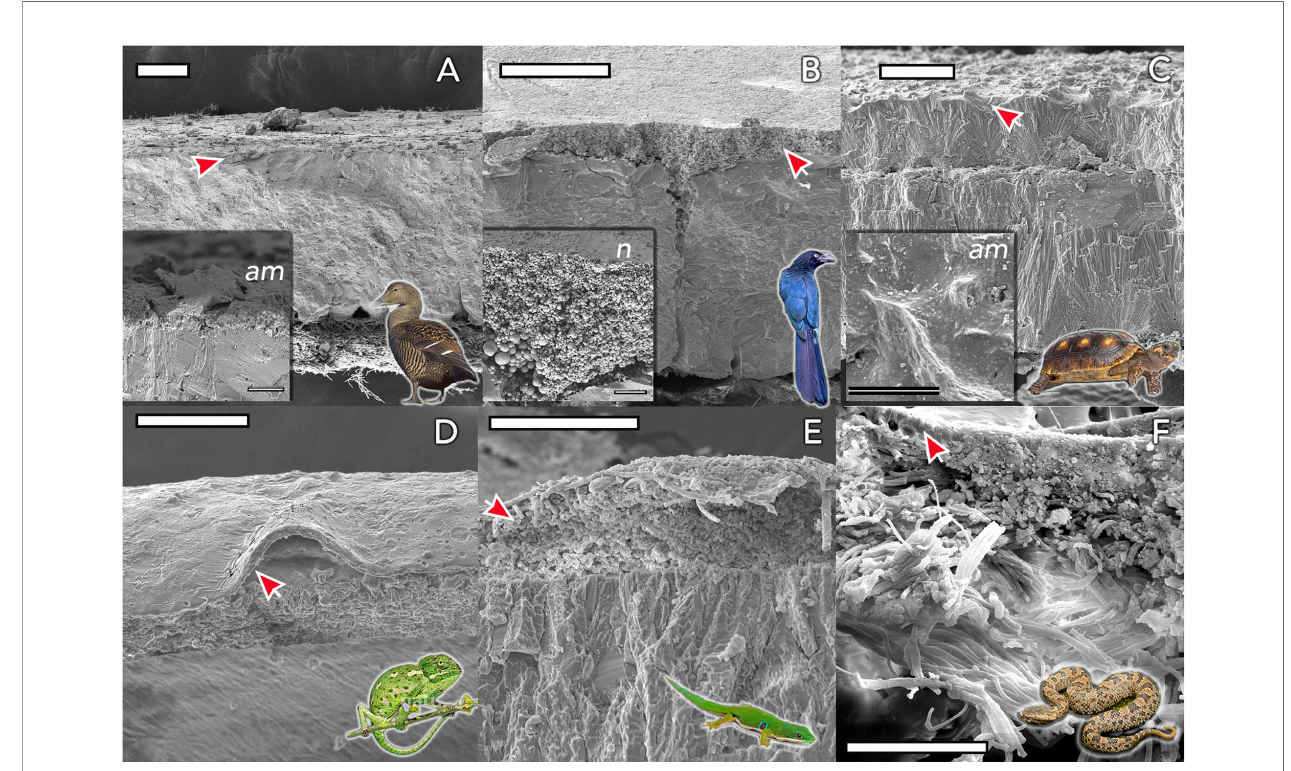
FIGURE 4 | Eggshell ultrastructure in representative species of amniote vertebrates. The eggshell cuticle (arrows) is the most super fi cial layer covering the calci fi ed or fi brous shell. (A) Common eider ( Somateria mollissima) ; (B) Great ani (Crotophaga major); (C) red-footed tortoise ( Chelonoidis carbonarius ); (D) Mediterranean chameleon ( Chamaeleo chamaeleon); (E) Madagascar day-gecko ( Phelsuma madagascariensis ); (F) Mountain pit viper ( Ovophis monticola ). Insets show detail of representative amorphous ( am ) and nanostructured ( n ; nanospheres) cuticles. Scale bars: (A, B, D) -100 m m; (C) - 200 m m; (E, F) - 50 m m. (Original fi gure by